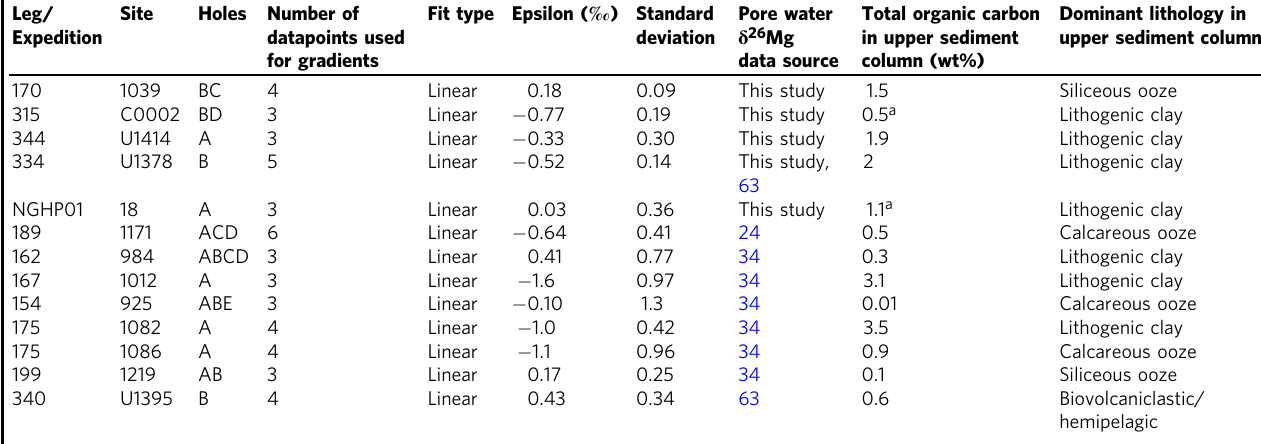
Table 2 Ocean-sediment magnesium fractionation model parameters Leg/ Site Holes Number of Expedition datapoints used